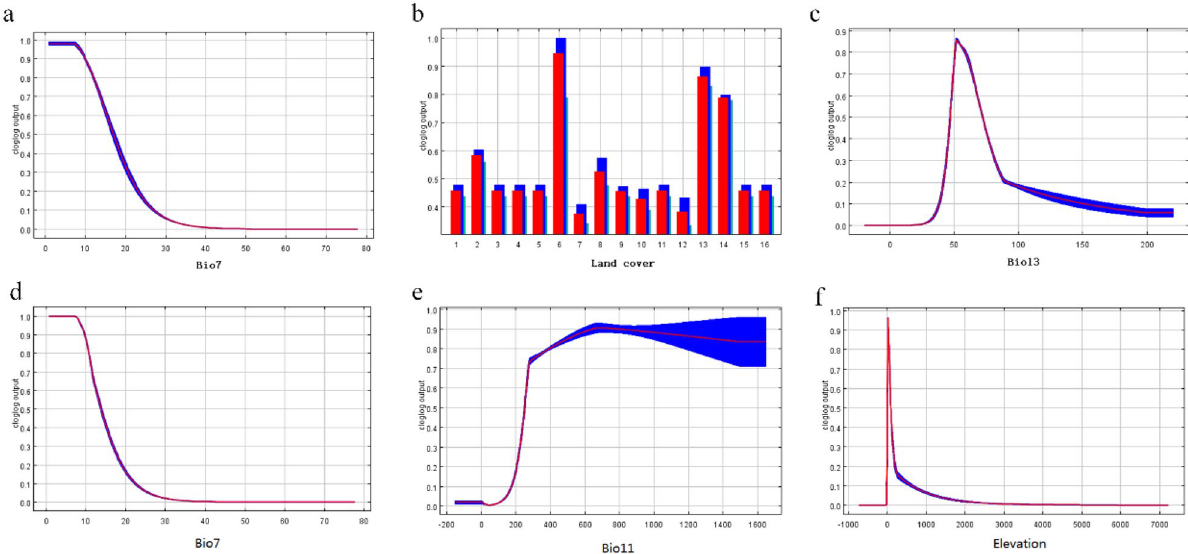
Figure 5. Response curves of the most significant environmental variables in mapping suitable areas of O. monoceros ( a – c ) and O. rhinoceros ( d – f ). Note: In part b, 1–16 means evergreen needleleaf forests, evergreen broadleaf forests, deciduous needleleaf forests, deciduous broadleaf forests, mixed forests, closed shrublands, open shrublands, woody savannas, savannas, grasslands, permanent wetlands, croplands, urban and built-up lands, cropland/natural vegetation mo-saics, permanent snow and ice, and barren,